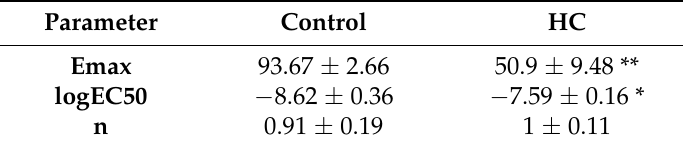
Table 5. Regression parameters (expressed in mean ± SEM) of the Hill equation fitted to the individual modified acetylcholine (Ach) concentration-response (E/c) curves. Level of statistical significance for differences between the Control and HC groups is indicated (* p < 0.05; ** p < 0.01). E max : maximal effect; logEC 50 : common logarithm of EC 50 , the concentration producing half-maximal effect; n: Hill coefficient (slope factor).